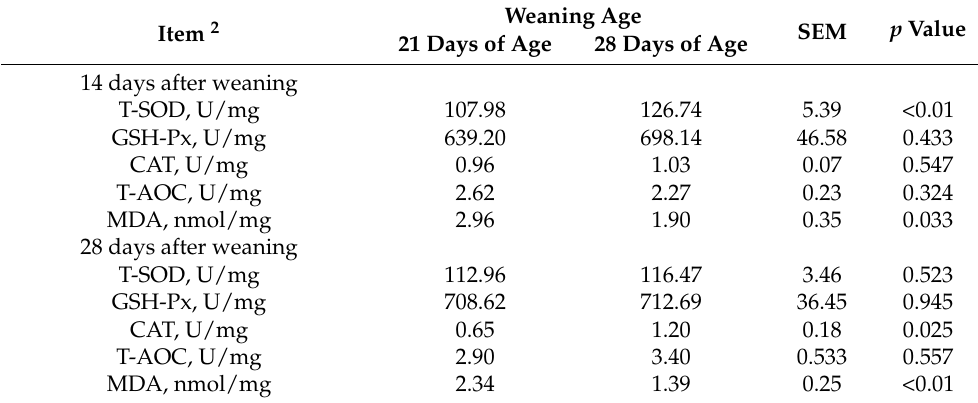
Table 8. Effect of weaning age on heart antioxidant indexes of weaned pigs 1